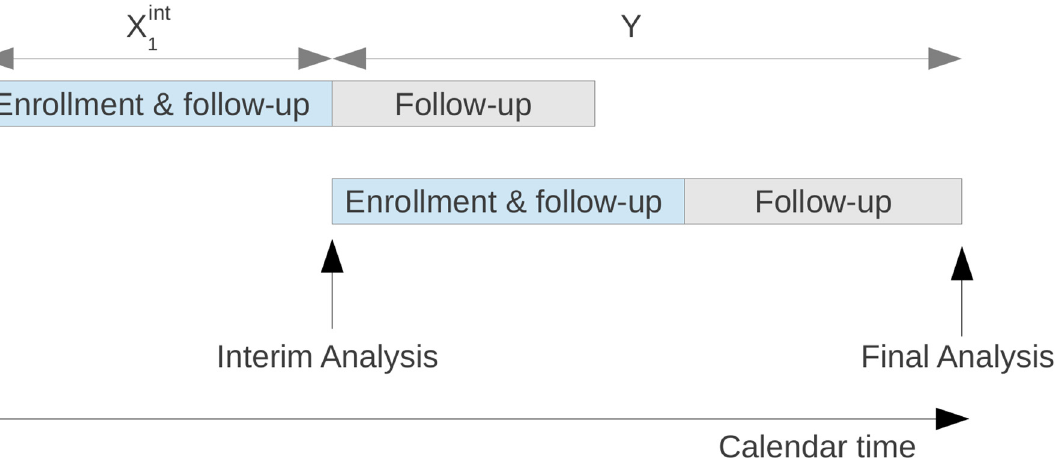
Fig 1. Schematic of a two-stage adaptive trial design with delayed response using the independent increments assumption.